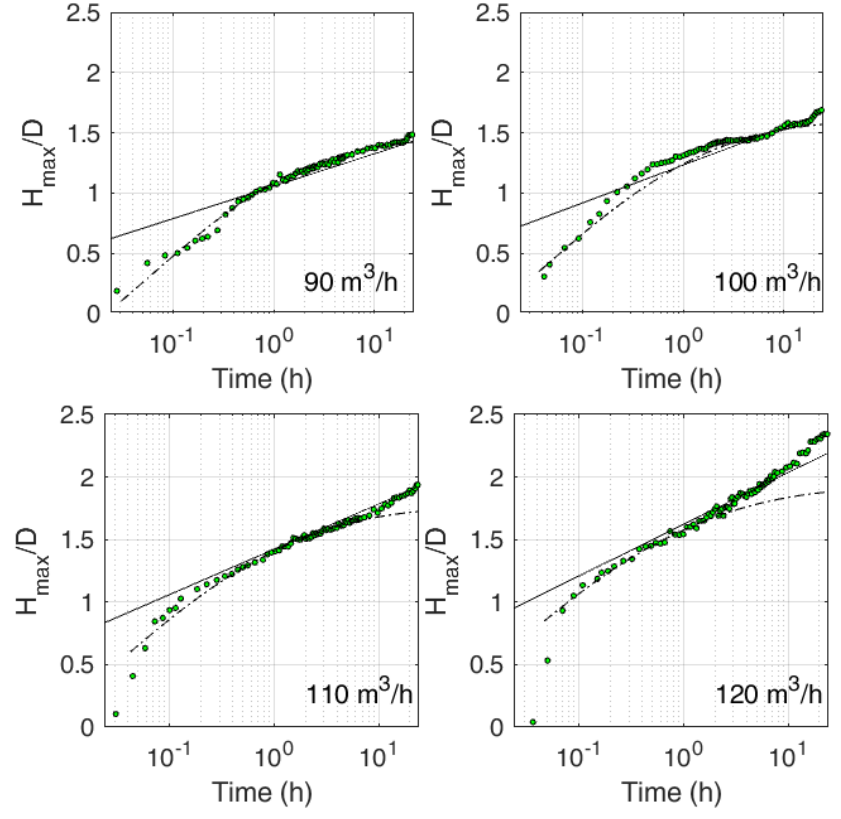
Figure 6. Time evolution of the maximum scour depth measured ( dots ) versus the estimation from Oliveto and Hager [16] ( solid line ) and Melville and Chiew [2] ( dash-dot line ).